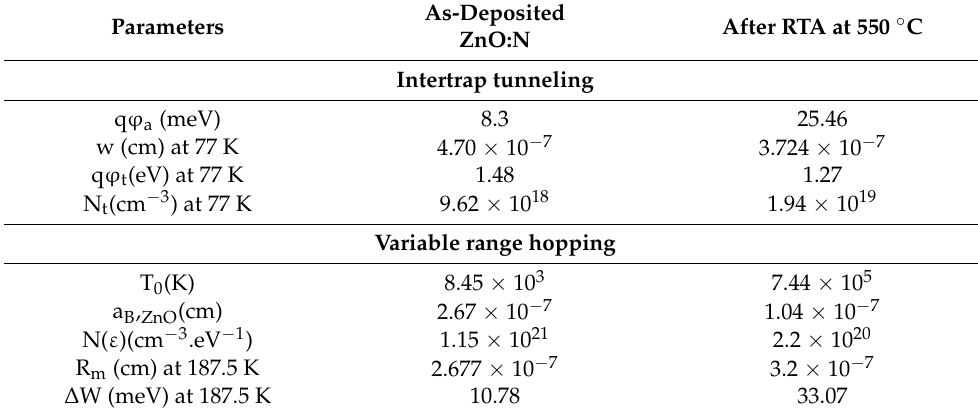
Table 4. Intertrap tunneling and variable range hopping parameters of ZnO:N films deposited at gas ratio of Ar:O 2 :N 2 = 50:10:40 (sample 2.1) and treated by RTA at 550 ◦ C (sample 2.1): q ϕ a —effective thermally activation energy; w—mean distance between deep levels; q ϕ t and N t —energy position and density of deep levels, respectively, in the ZnO energy gap; T 0 —characteristic temperature; a B,ZnO —Bohr radius of the localized states in the ZnO energy gap; N( ε )—density of localized states; R m and ∆ W—most probable hopping distance and energy difference of deep levels, respectively. As-Deposited After RTA at 550 ◦ C Parameters ZnO:N Intertrap tunneling q ϕ a (meV) 8.3 w (cm) at 77 K q ϕ t (eV) at 77 K N t (cm − 3 ) at 77 K Variable range hopping T 0